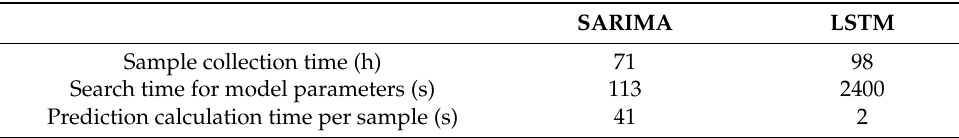
Table 8. Comparison of algorithm stage